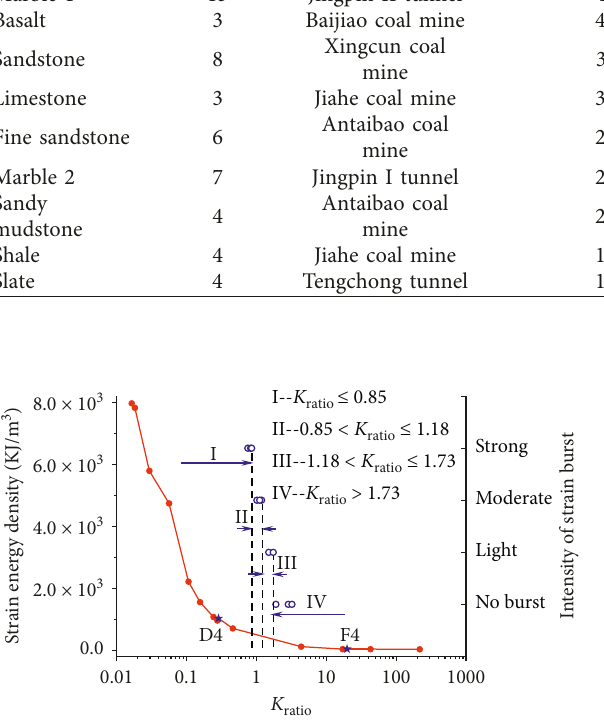
Figure 13: The comparison of the stiffness ratio obtained from the numerical and experimental tests,